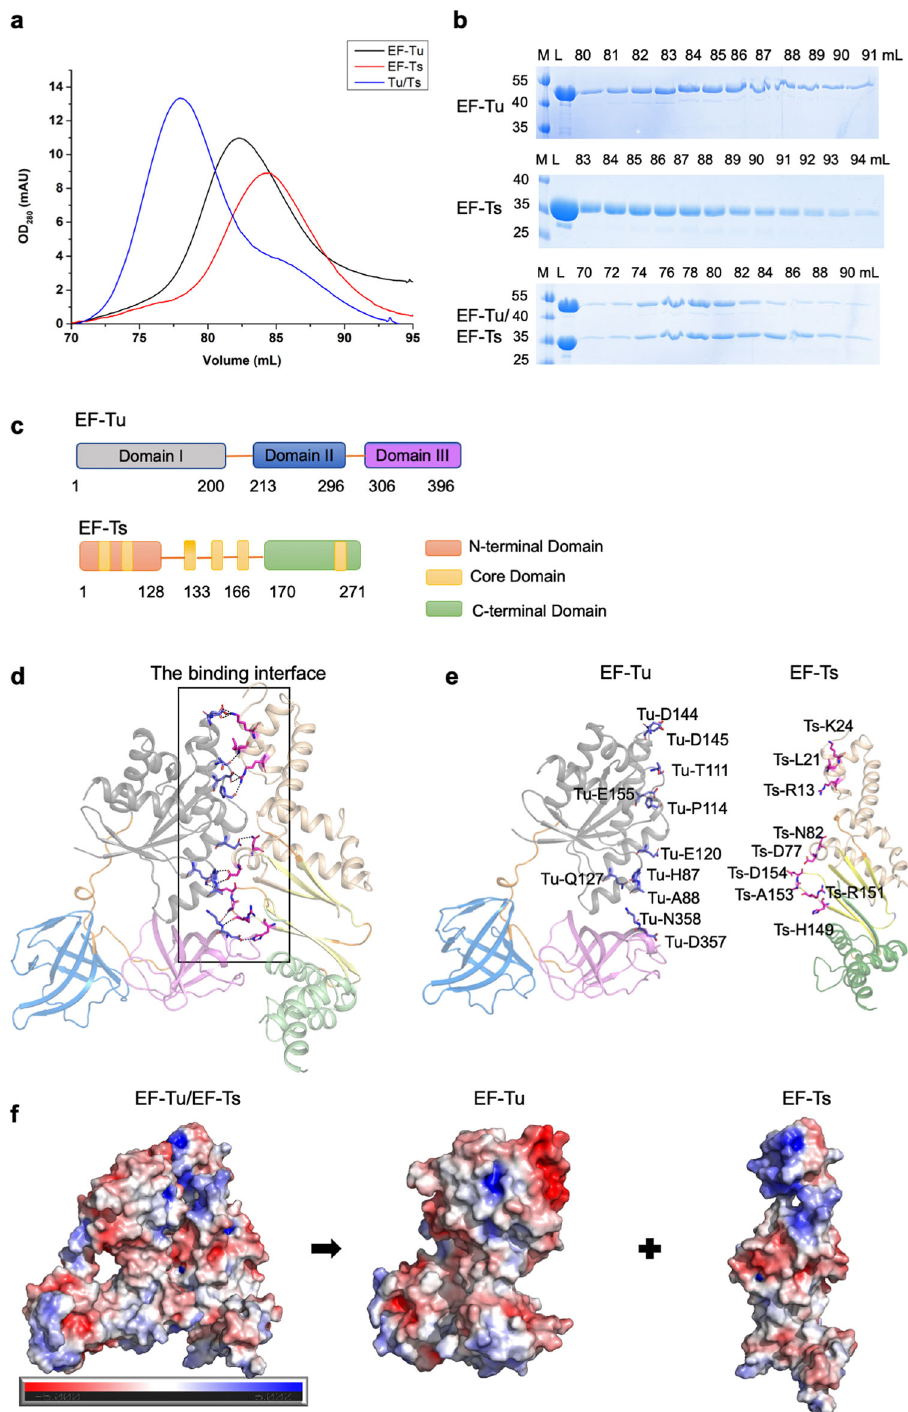
Fig. 1 Crystal structure of Mtb EF-Tu (cid:129) EF-Ts complex. a The size-exclusion chromatography (SEC) pro fi les of Mtb EF-Tu, EF-Ts, and EF-Tu (cid:129) EF-Ts complex on a Superdex200 16/600 column. b The SDS-PAGE results of EF-Tu, EF-Ts, and EF-Tu (cid:129) EF-Ts complex, corresponding with ( a ). M protein marker, L protein loading sample. c Schematic domains of Mtb EF-Tu and EF-Ts. EF-Tu consisted of three domains, including Domain I (gray), Domain II (blue), and Domain III (purple). EF-Ts consisted of three domains, including the N-terminal domain (wheat), the C-terminal domain (green), and the core domain in the middle (yellow). d A ribbon representation of Mtb EF-Tu (cid:129) EF-Ts complex structure, colored with that in ( c ). EF-Tu and EF-Ts formed a 1:1 symmetric complex. The binding interface was labeled with a black rectangle for key residues depicted with stick models, and the cartoon is shown with a 50% transparency to highlight the key residues. e A ribbon representation of the detailed binding interface between EF-Tu and EF-Ts. The involved key residues were labeled and shown as sticks. f The electrostatic potential surfaces of Mtb EF-Tu (cid:129) EF-Ts complex (left), EF-Tu (middle), and EF-Ts (right). Red denoted negative potential, and blue denoted positive potential.